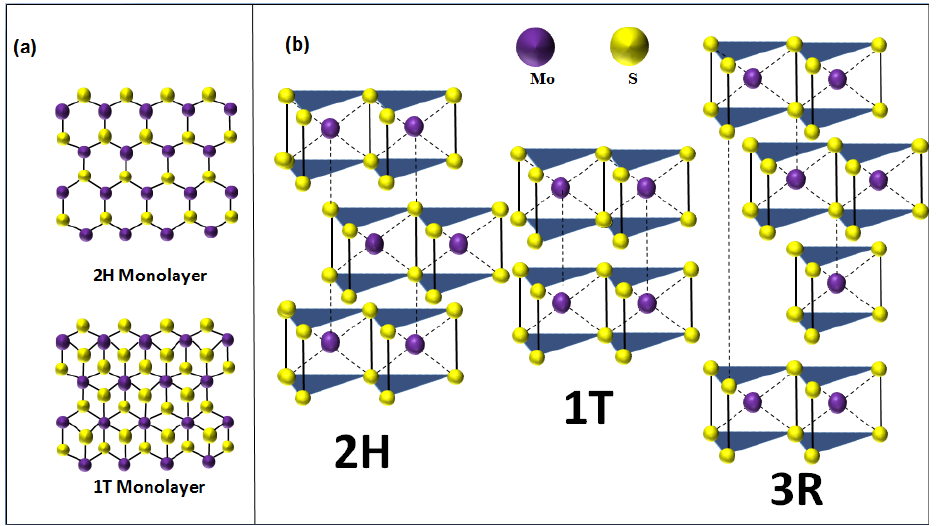
Figure 1. ( a ) Top view of 2H/1T MoS 2 monolayer. ( b ) Polymorphic structures of MoS 2 (2H is the hexagonal crystal form, 1T is the tetragonal crystal form, and 3R is the rhombohedral crystal form). Table 1. Crystal parameters and the nature of polymorphic structures of 2D-MoS 2.